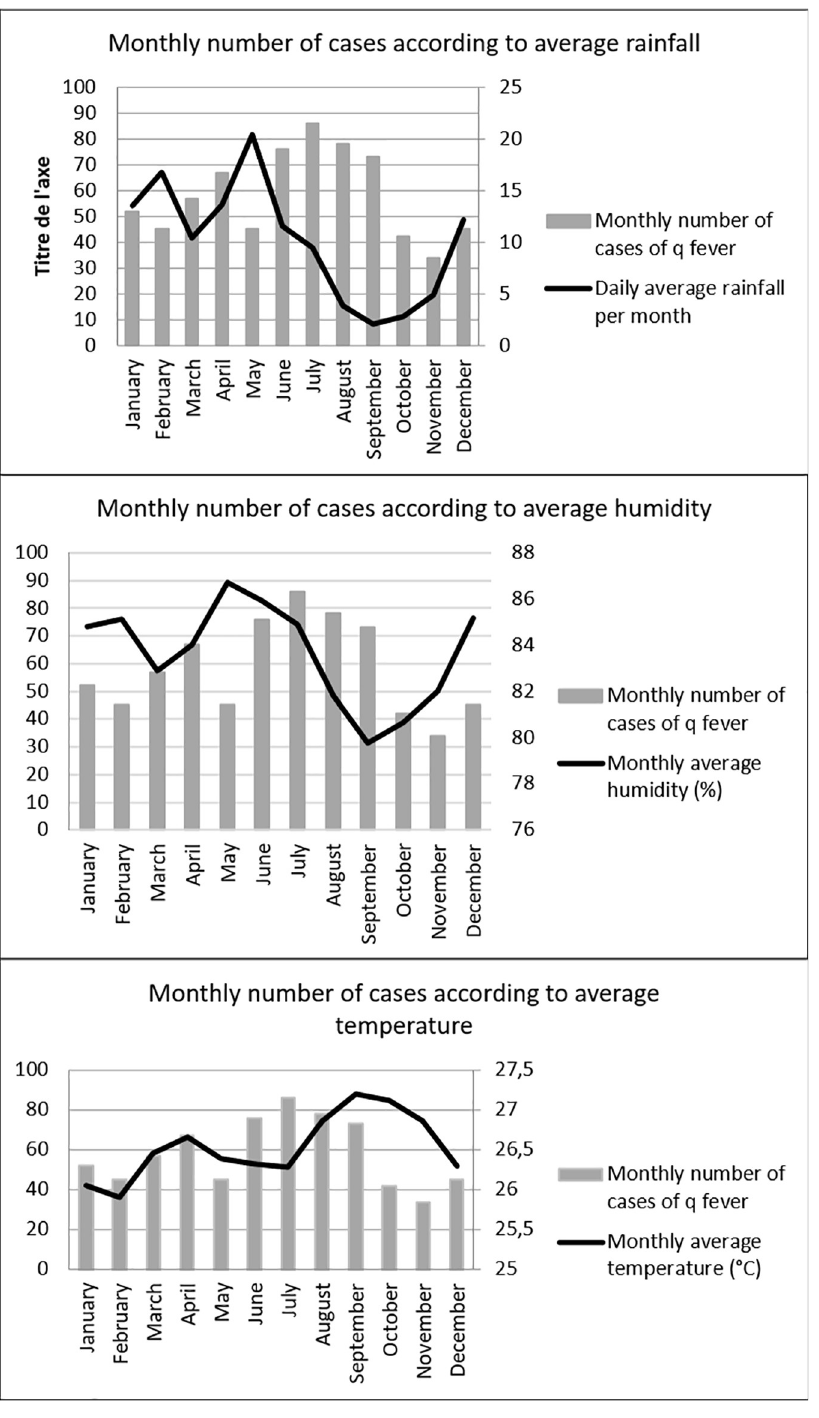
Fig 6. Monthly distribution of the cases of Q fever between 2007 and 2017 according to three climate variables: rainfall, humidity and temperature.